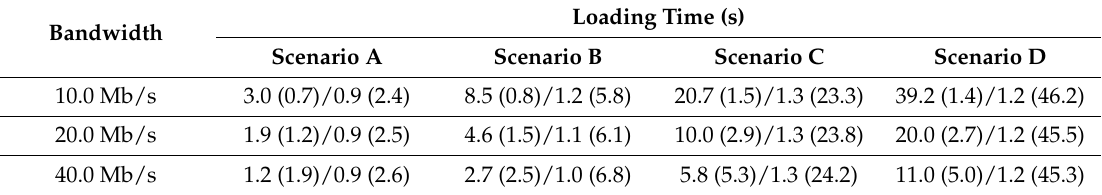
Table 6. Web rendering statistics obtained for the different scenarios proposed. The ratio between the size of the model (in Mb) and the time spent to load the model (in s) is indicated in